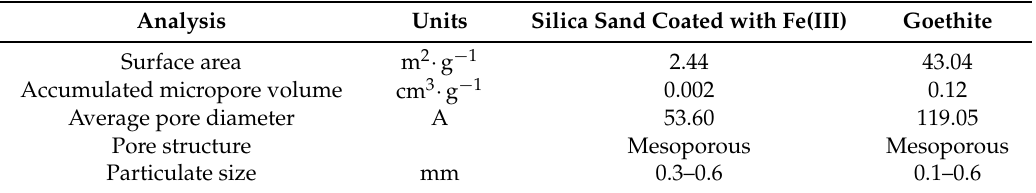
Table 4. Characterization of the adsorbent media obtained in the laboratory.